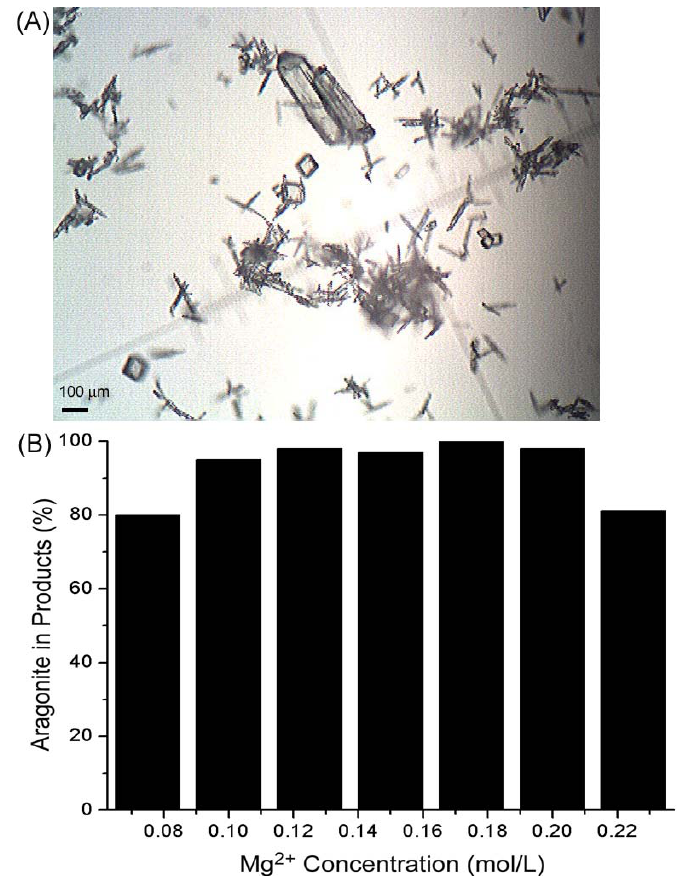
Figure 2. ( A ) Optical image of the product obtained with MgCl 0.075 mol ⋅ L − 1 ; ( B ) Variation of aragonite production with Mg 2+ concentration when the Ca 2+ is fixed at 0.36 mol ⋅ L − 1